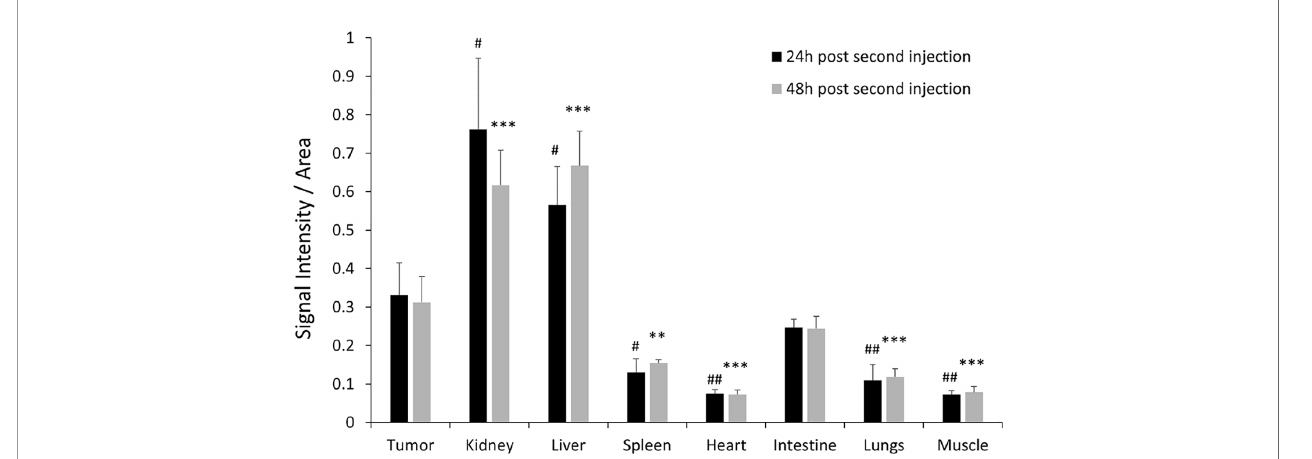
FIGURE 3 | Ex vivo PD-L1 siRNA dextran NP biodistribution in orthotopic tumors. Quanti fi cation of fl uorescent signal intensity in tumors, kidneys, liver, spleen, lungs, heart, intestine, and muscle measured ex vivo after PD-L1-siRNA dextran NP treatment 24 h after the second injection (group 1, black bars, n = 4) and 48 h after the second injection (group 2, grey bars, n = 5). # p < 0.05, ## p < 0.01 (compared to the signal measured in the tumor 24 h post second injection). **p < 0.01, ***p < 0.005 (compared to the signal measured in the tumor 48 h post second injection).